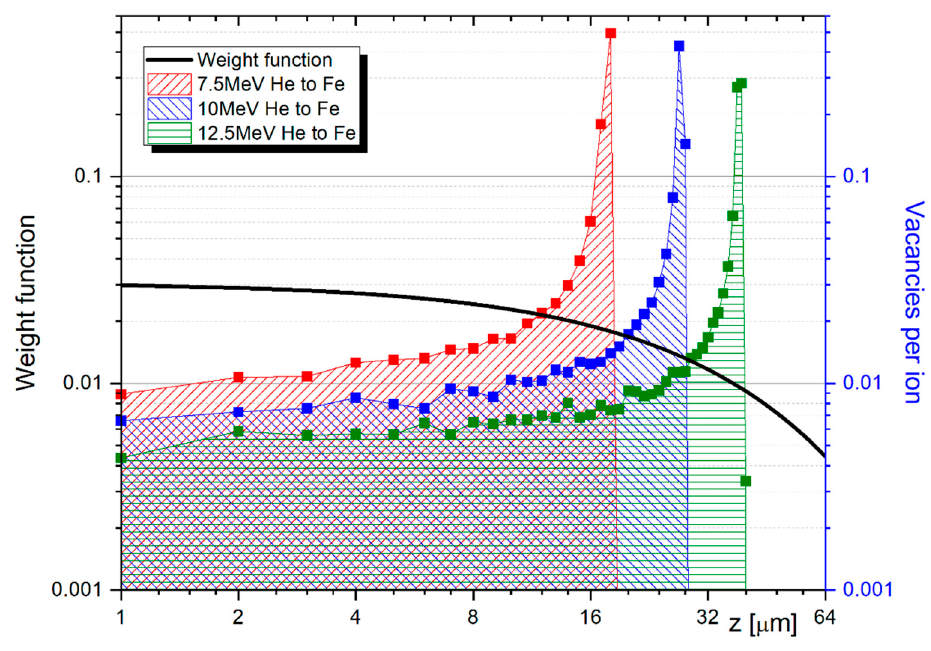
Figure 7. Depth profiles of vacancies distribution according to implantation energies. The weight function characterising the stopping of positrons from the 22 Na source was obtained from the experiment illustrated in Figure 4 and depicted the logarithmic scale.